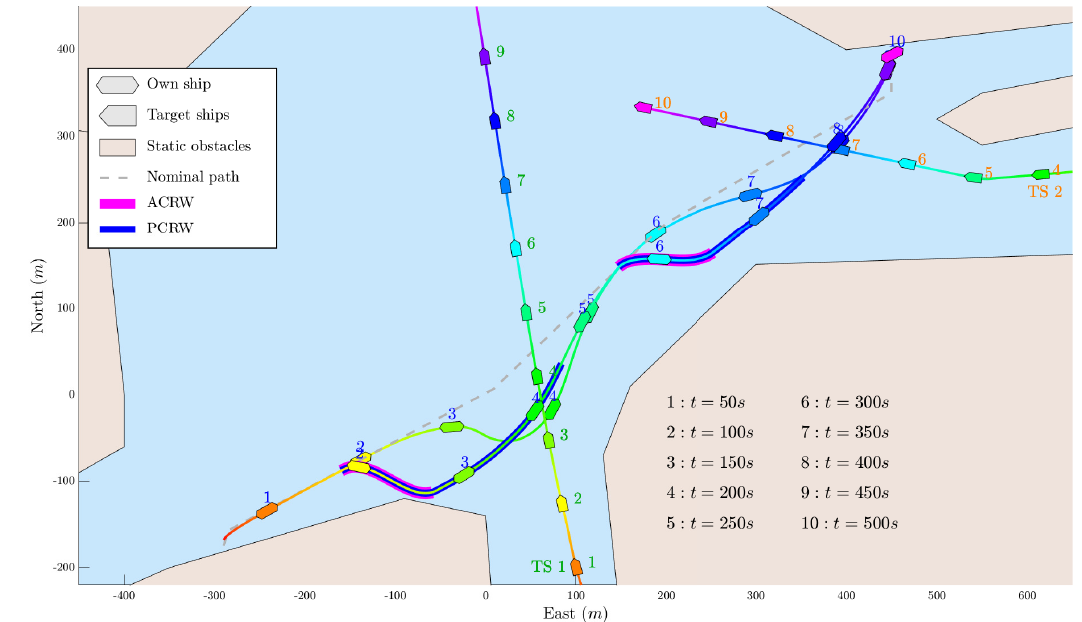
Figure 15: Simulation 1: Transit between two docking locations where the OS encounters two TSs in give-way encounters. The figure includes the OS trajectory for a run with and without CRWs. The TSs have identical behaviour in both